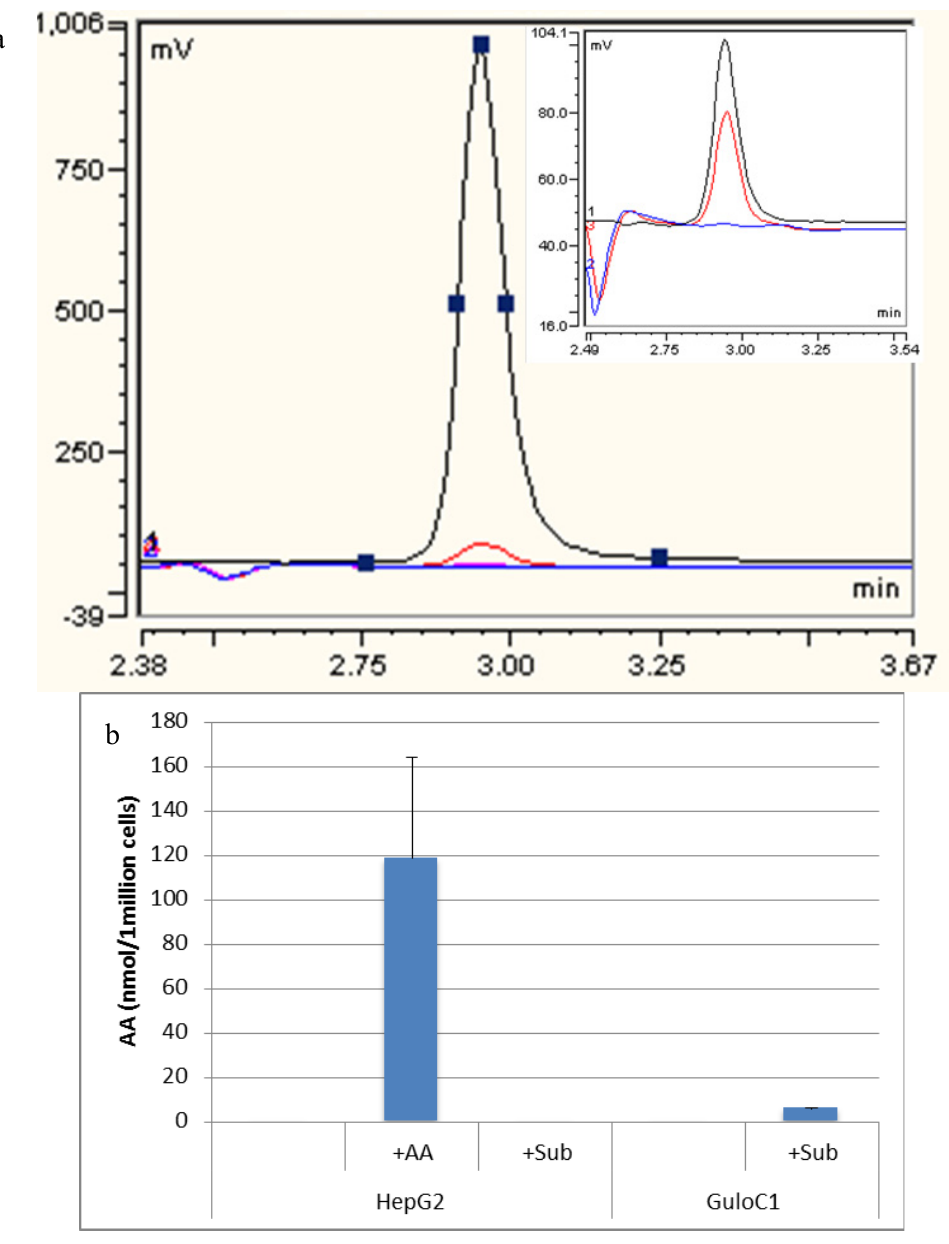
Figure 4. Detection of ascorbate by HPLC. ( a ) Representative HPLC-ECD traces of assessment of HepG2 GuloC1. Blue : HepG2; Black : HepG2 + 500 µM ascorbate diluted 1/10; Red : HepG2 GuloC1 + 500 µM gulonolactone; Pink : 500 µM gulonolactone. Insert: Blue : HepG2; Black : ascorbate 2.5 µM standard; Red : HepG2 GuloC1 + 500 µM gulonolactone; ( b ) Amount of ascorbate detected by HPLC-ECD in HepG2 parental and HepG2 GuloC1 cells. +AA = 500 µM ascorbate added, +Sub = 500 µM gulonolactone added ( n = 3, mean ascorbate per 1 million cells ±